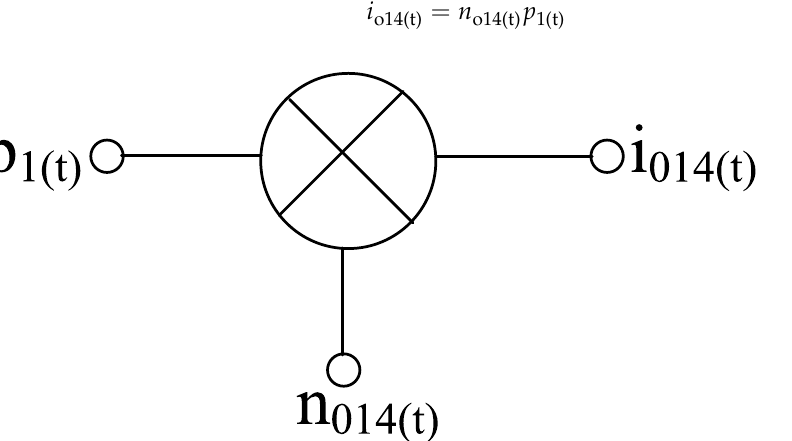
Figure 12. Mixer operation for transconductance